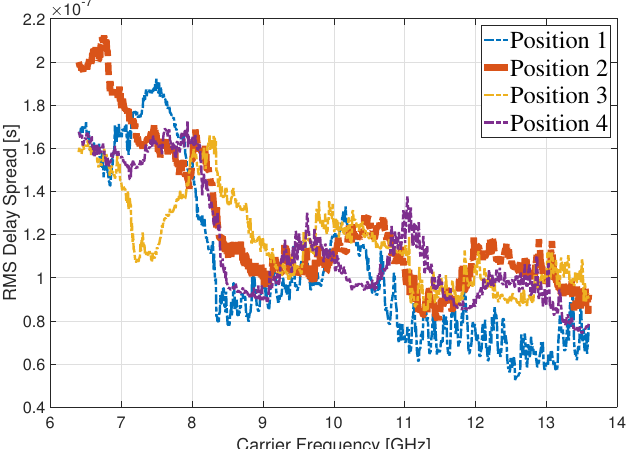
Figure 6. The RMS delay spread versus carrier frequency observed at 4 user locations.